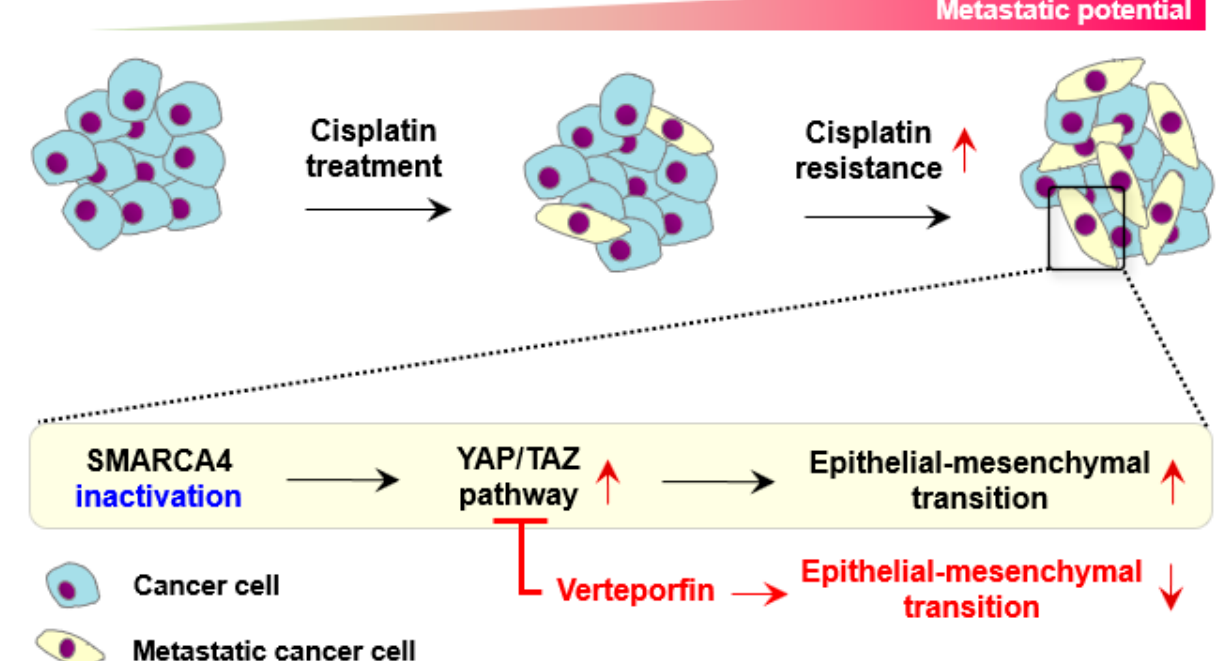
Figure 6. Hypothesis illustration to describe EMT regulation by SMARCA4 deficiency, and verteporfin to inhibit YAP in TNBC.